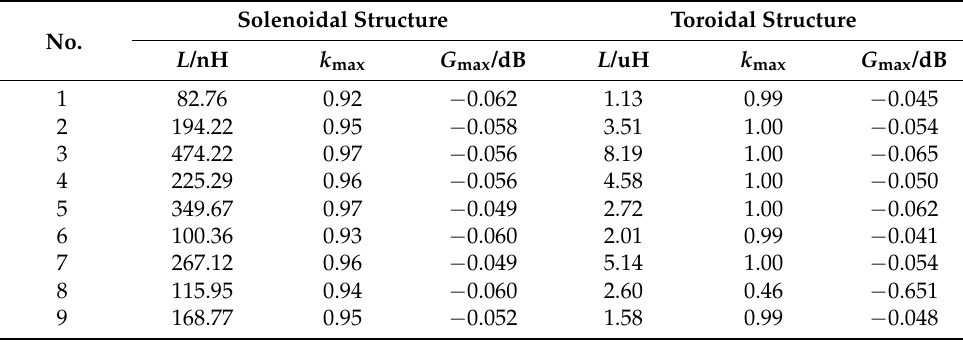
Figure 5. Effect of substrate on performance of transformer. ( a ) Solenoidal and ( b ) toroidal. Table 6. Simulation result of ferrite core